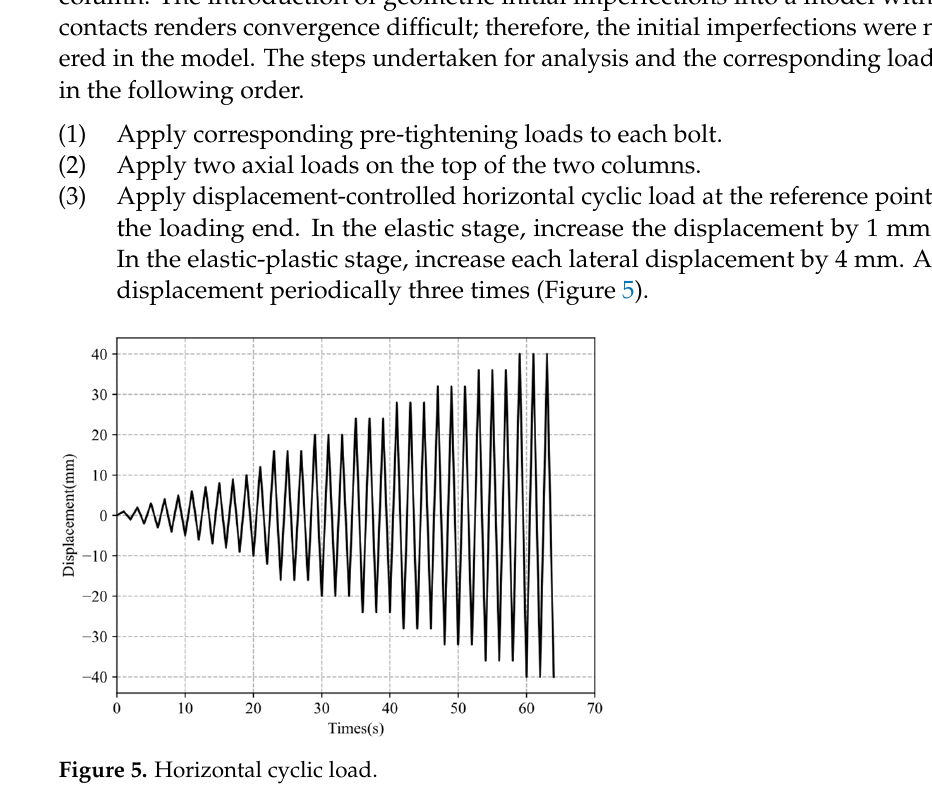
Figure 5. Horizontal cyclic load.